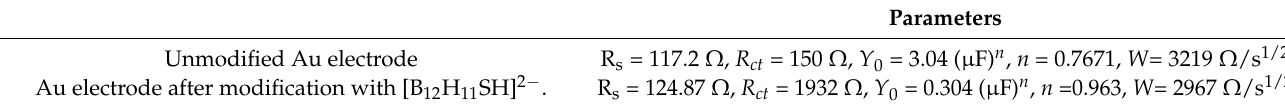
Table 1. Parameters of the Randles circuit fitted to the impedance spectra. Parameters Unmodified Au electrode R s = 117.2 Ω , R ct = 150 Ω , Y 0 = 3.04 ( µ F) n , n = 0.7671, W = 3219 Ω /s 1/2 Au electrode after modification with [B 12 H 11 SH] 2 − .